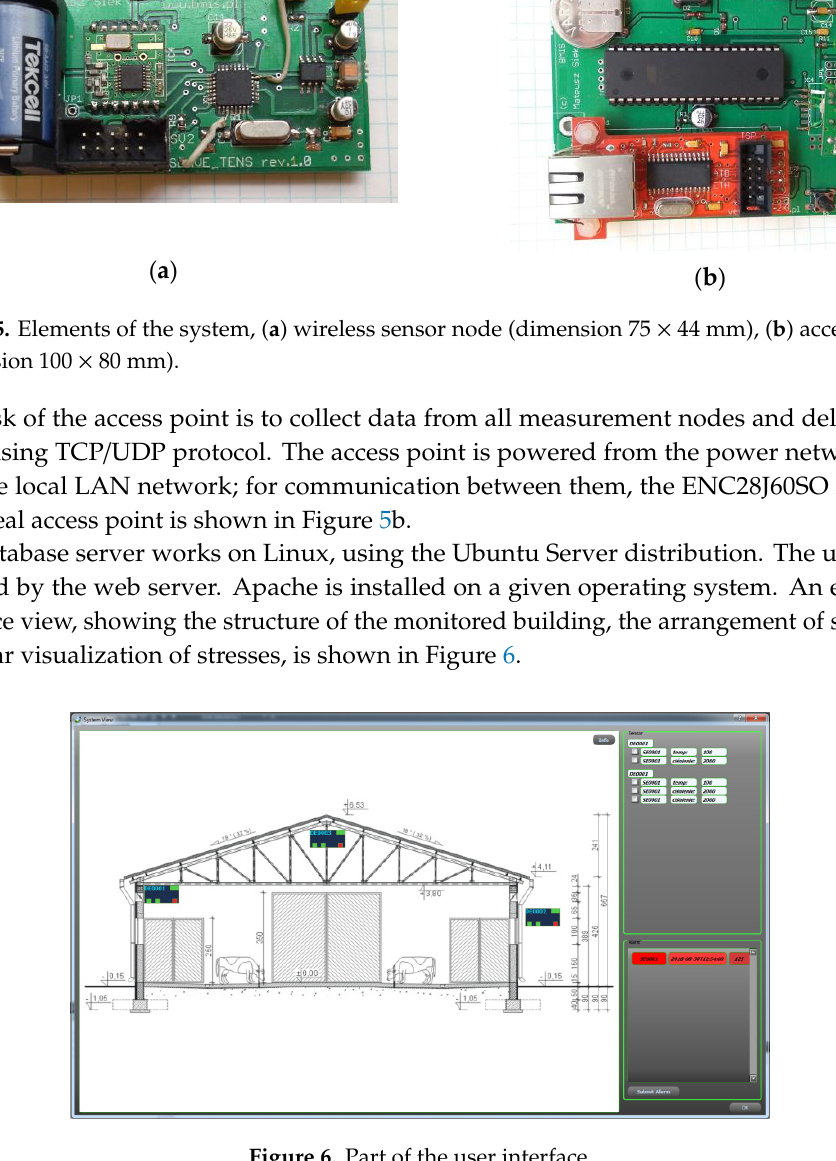
Figure 6. Part of the user interface.